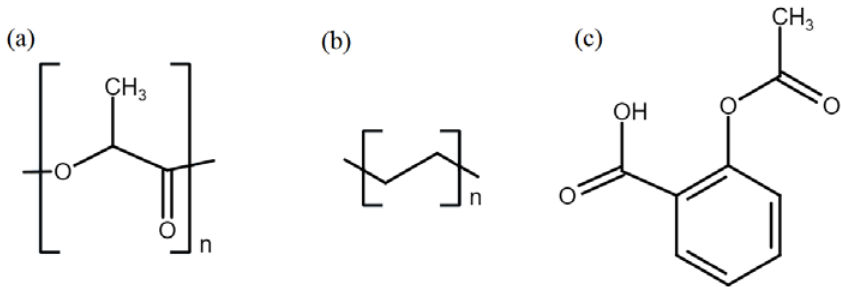
Figure 1. Chemical structures of ( a ) PLLA, ( b ) LLDPE, and ( c ) aspirin.